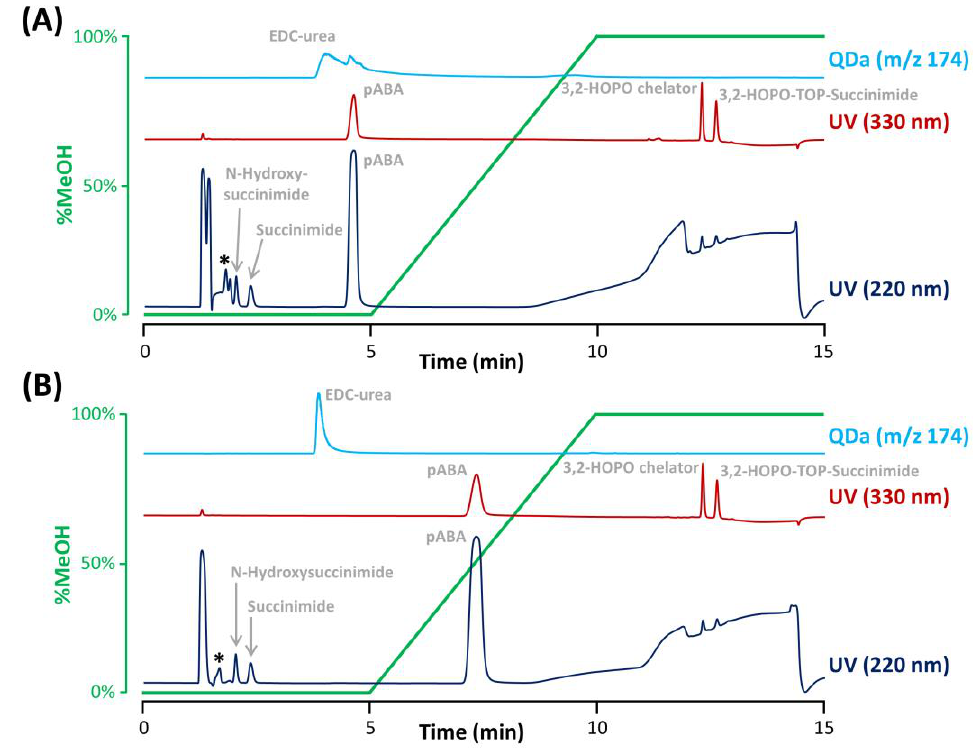
Figure 3. Separation of the ACC impurities and formulation components performed on the Synergi Polar RP column with an aqueous mobile phase containing ( A ) 0.1% TFA without pH adjustment or ( B ) 0.075%TFA and pH adjustment at 2.6 with ammonium hydroxide. An asterisk denotes the elution of citric acid and EDTA. The gradient profile was reported in green.